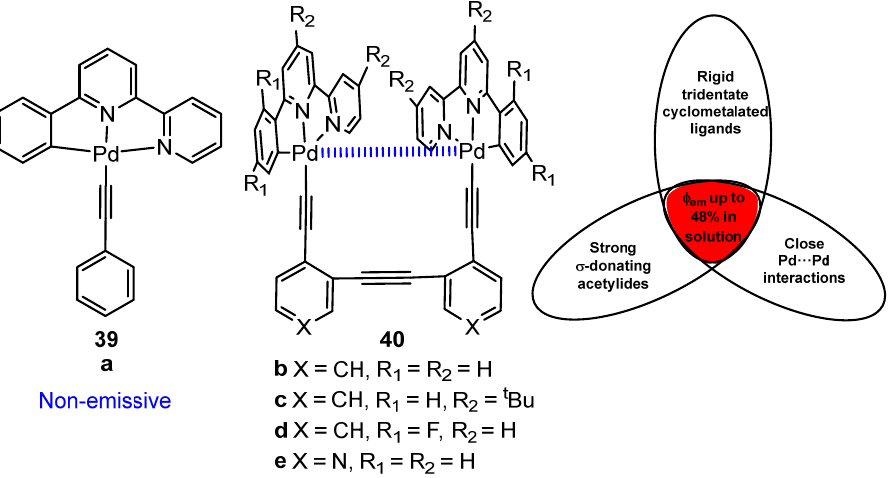
Figure 12. Chemical structures of pincer-cyclometalated Pd(II) arylacetylide complexes 39 and 40 . Structural features of the phosphorescent dinuclear Pd(II) 40 are highlighted in the right. Adapted from [73].